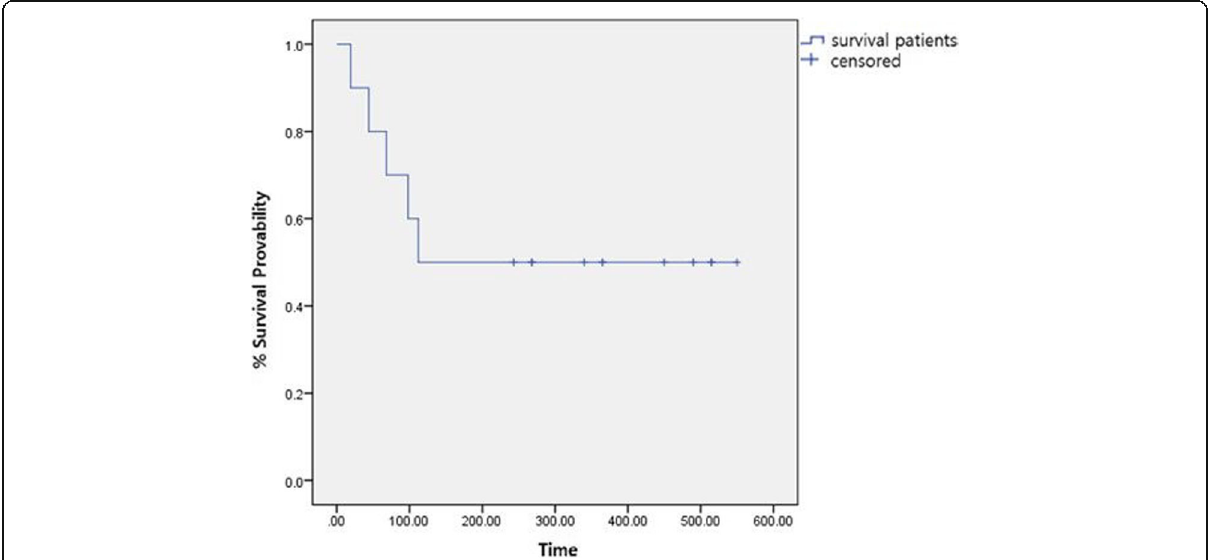
Fig. 4 Kaplan-Meier survival plot for all patients with tumor-related GI bleeding (time represented in days)